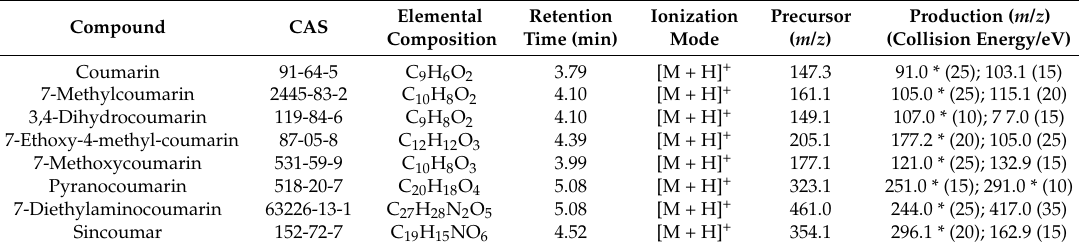
Figure 2. MS/MS spectra of coumarin using different collision energies (15, 20, 25 and 30 eV). Table 1. Elemental composition, retention time, MS/MS parameters for coumarin and its derivatives ( * Quantitation ion pair).